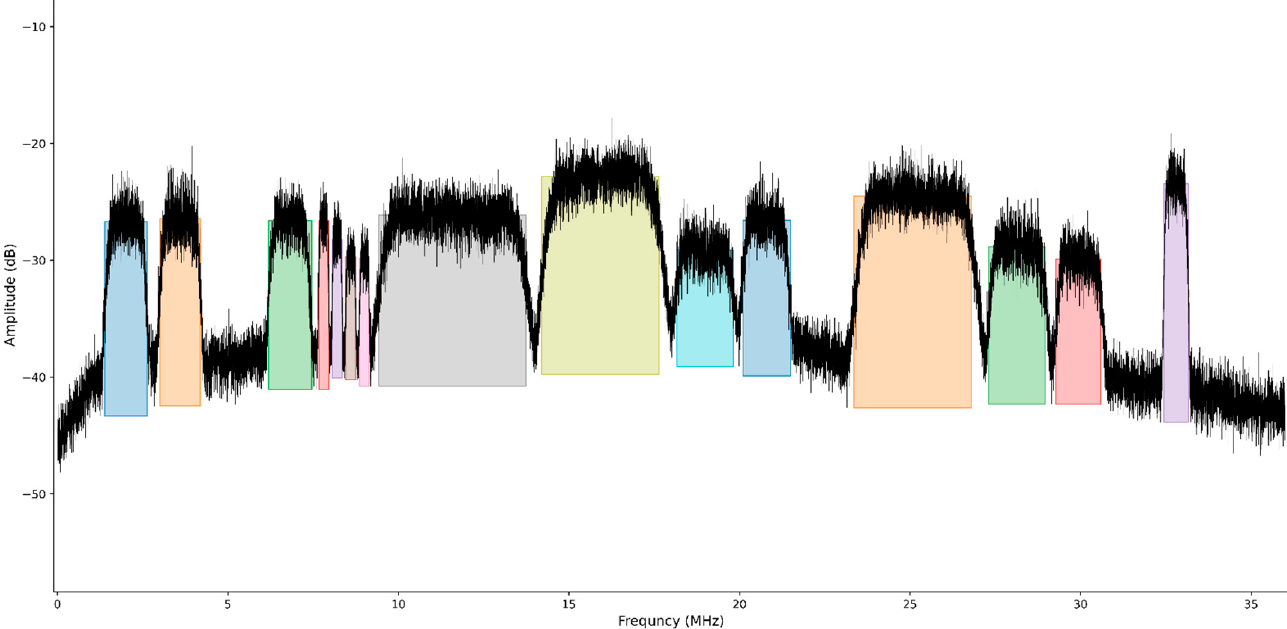
Figure A7. Example7 of the actual satellite broadband power spectrum set.